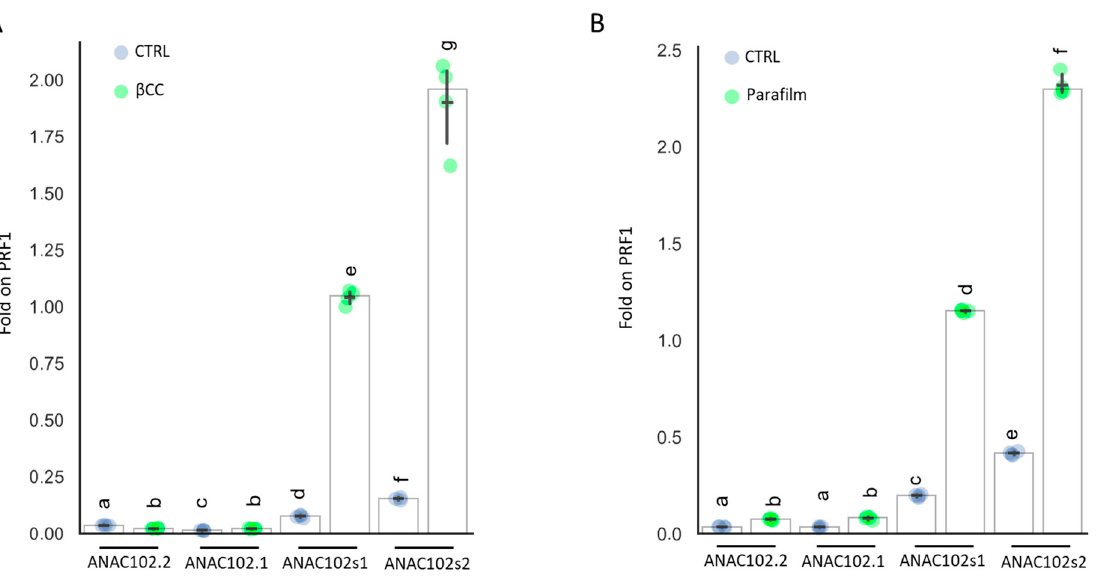
Figure 4. Expression of ANAC102 isoforms under control conditions (CTRL), adult plants treated with β -cyclocitral ( β CC) ( A ), or seedlings in Petri dishes sealed with parafilm (Parafilm). Results are presented as fold on PRF1 expression ( B ). White bars = median value, black dash = average. Error bar = confidence interval 95%. Data labeled with different letters are significantly different ( p < 0.05).